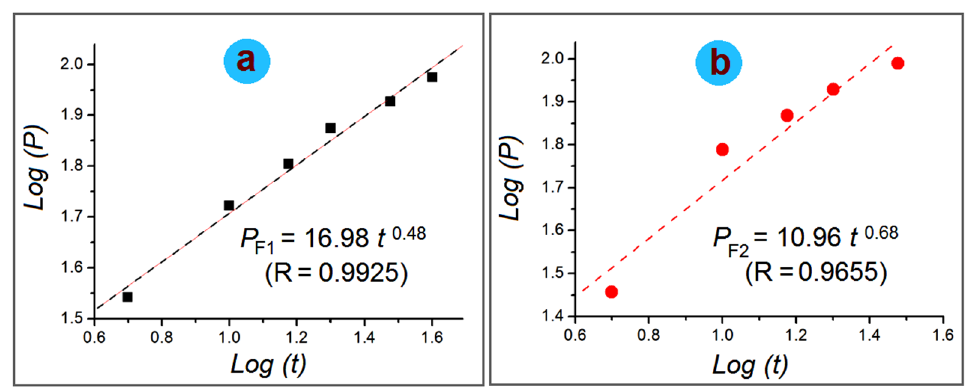
Figure 10. The drug release mechanism judgement: ( a ) the electrospun nanocomposites F1; ( b ) the electrospun core–shell nanohybrids F2.